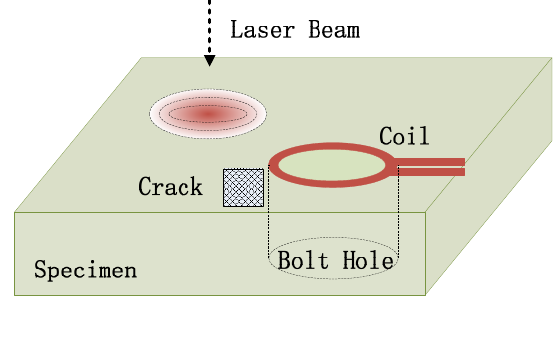
Figure 32. Inspection geometry of the photoinductive field measurement